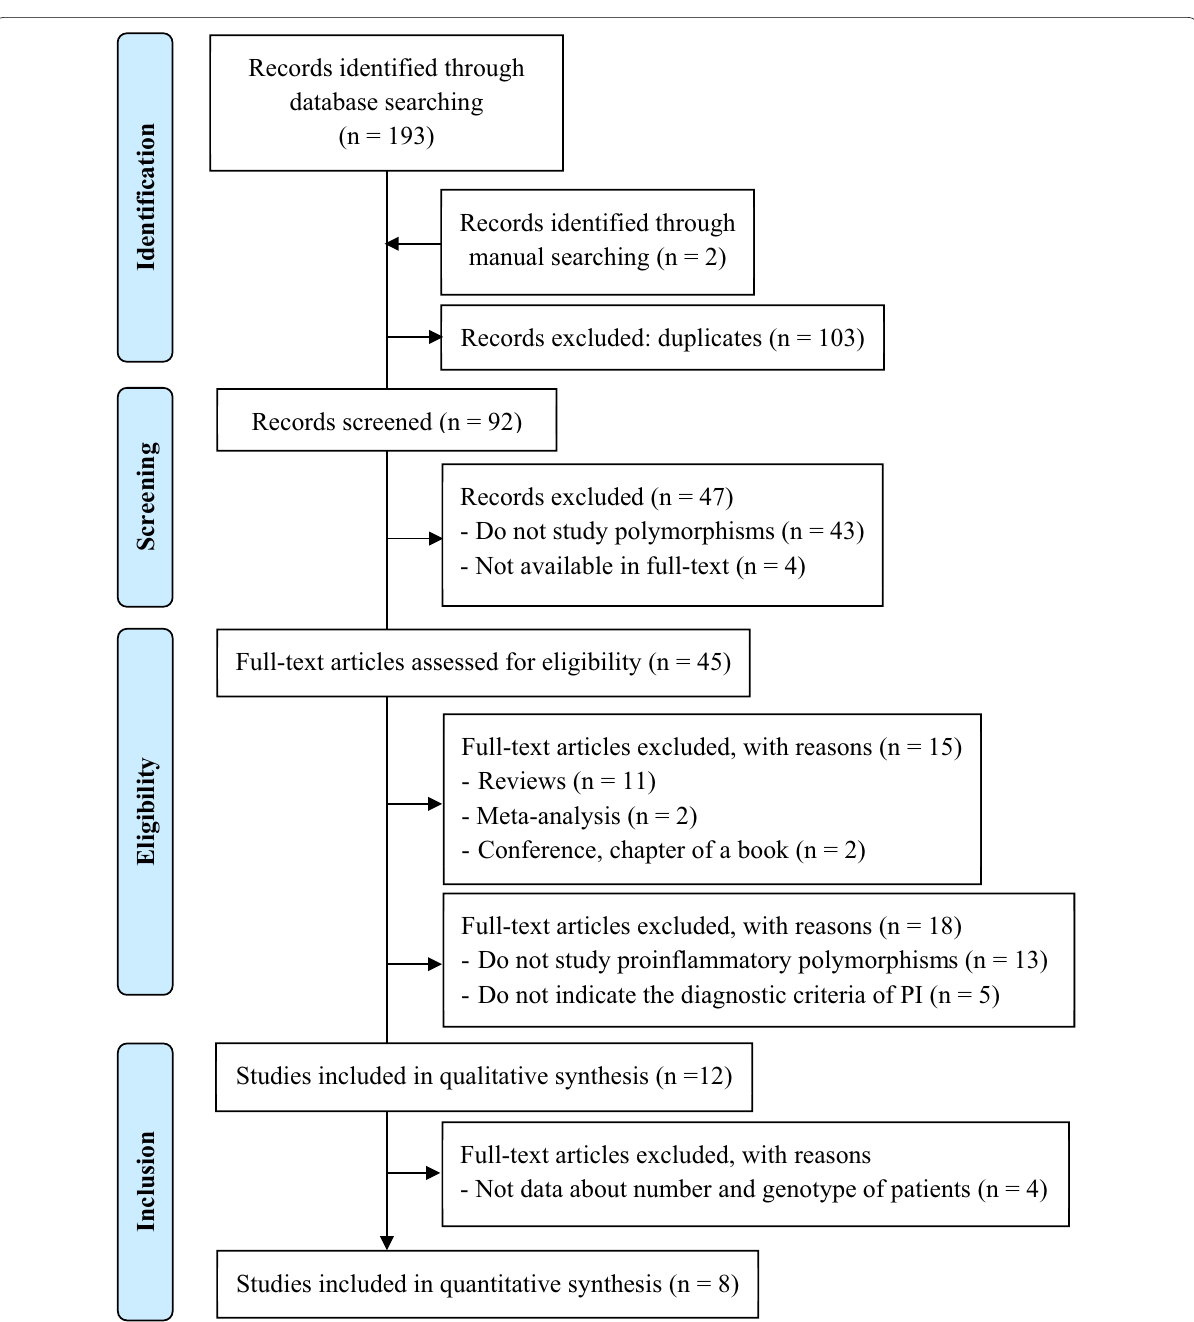
Fig. 1 PRISMA flow diagram. Synthesis of the selection process of the included articles in the